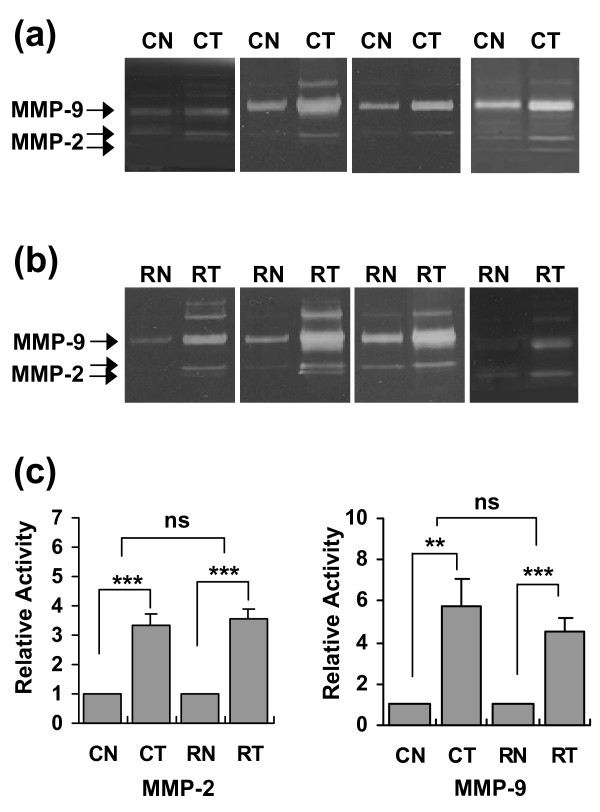
MMP-2 and MMP-9 activities analyzed by gelatinzymography. (a) Gelatin zymography of 4 representative specimens of colon tumor (CT) and the corresponding paired adjacent normal colonic mucosa (CN) from colon cancer patients. (b) Gelatin zymography of 4 representative specimens of rectal tumor (RT) and the corresponding paired adjacent normal rectal mucosa (RN) from rectal cancer patients. (c) Zymographic band densities from all tissue samples were quantified by densitometry. The relative enzyme activities of MMP-2 and MMP-9 are expressed as a mean ± SE. ns, non-significant. **P < 0.01. ***P < 0.001